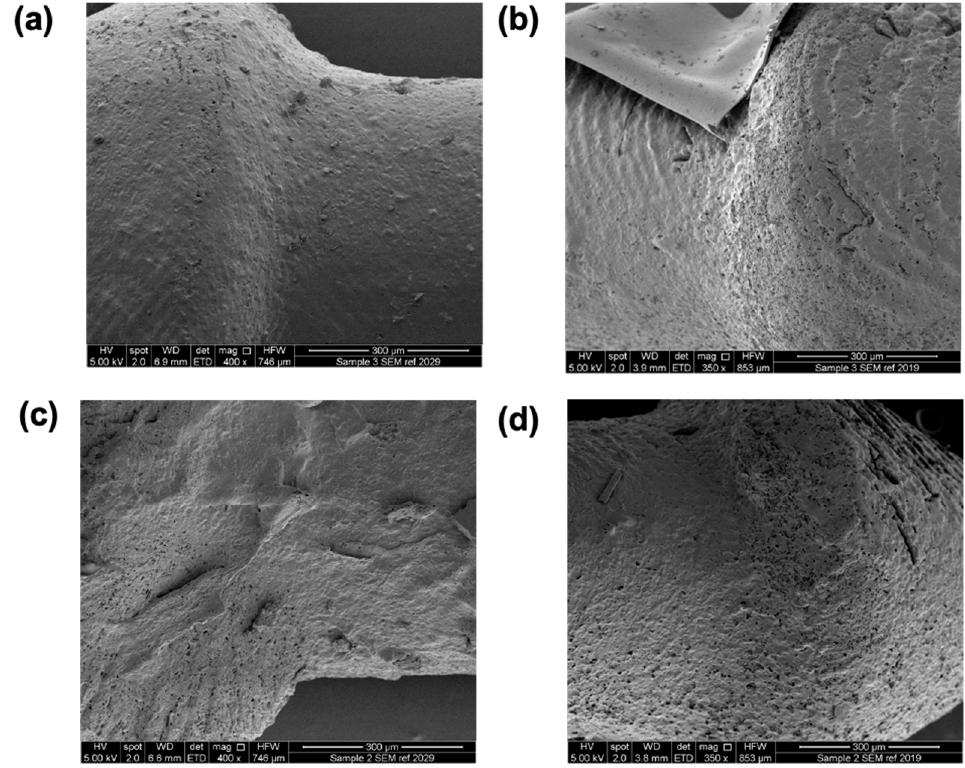
Figure 9. SEM images of DLP 3D printed ( a ) D10, ( b ) D10PEG, ( c ) D20, and ( d ) D20PEG punctal plugs after dissolution.